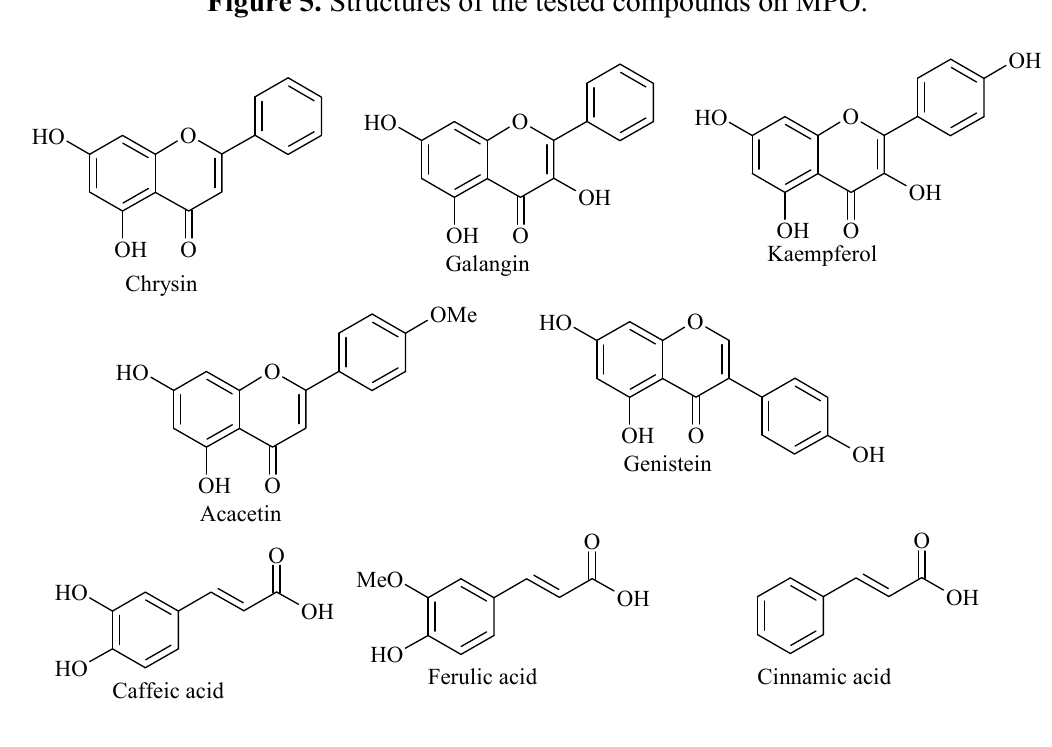
concentration of the ethyl acetate 50